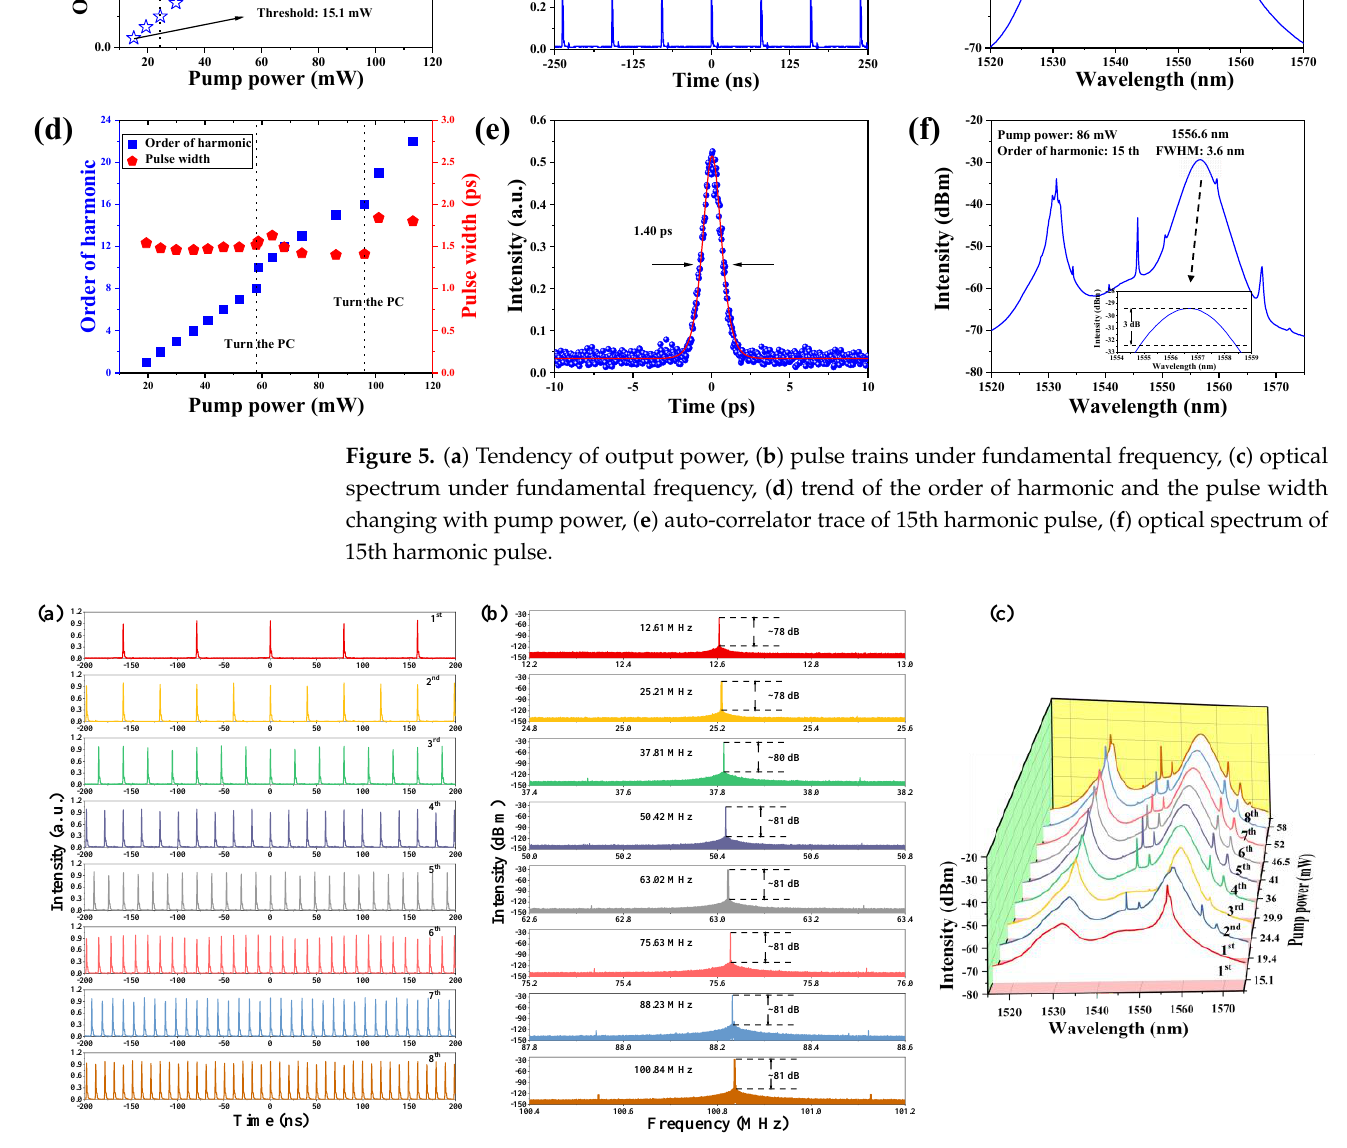
Figure 7. ( a ) Pulse trains from 10th-22nd, ( b ) corresponding RF spectra, ( c ) changing trend of the optical spectra of the harmonic order from 10th – 22nd.